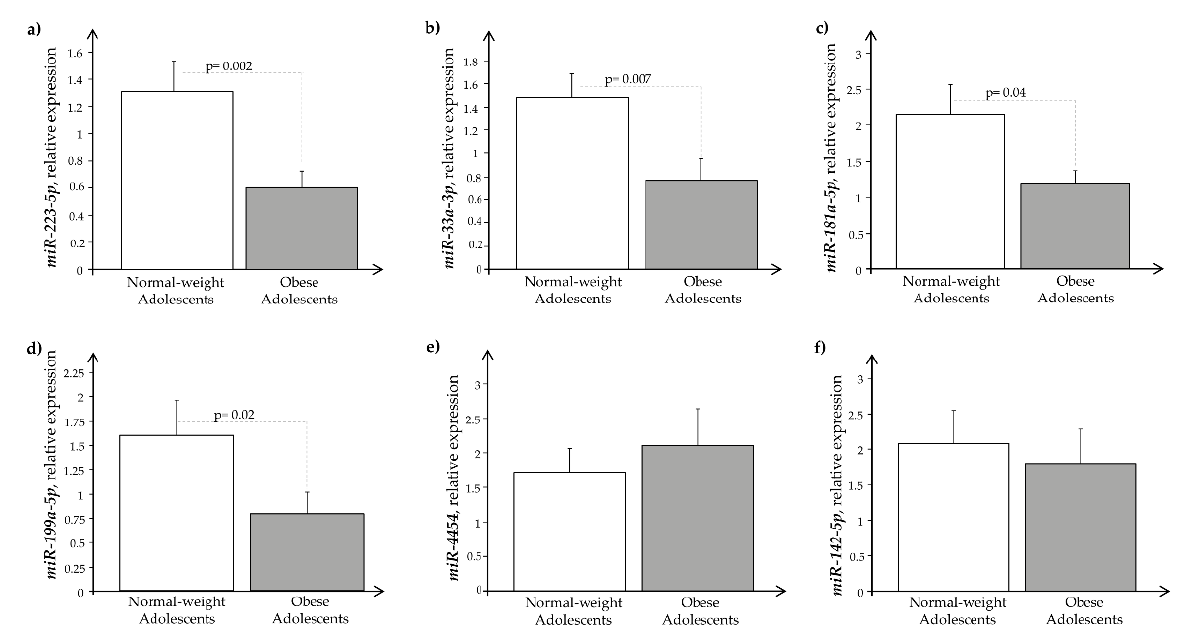
Figure 3. Expression level of exosomal miRNAs. ( a ) miR-223-5p , ( b ) miR-33a-3p , ( c ) miRNA-181a-5p , ( d ) miRNA-199-5p , ( e ) miRNA-4454 , ( f ) miR-142-5p in normal-weight (open bars) and obese subjects (closed bars).